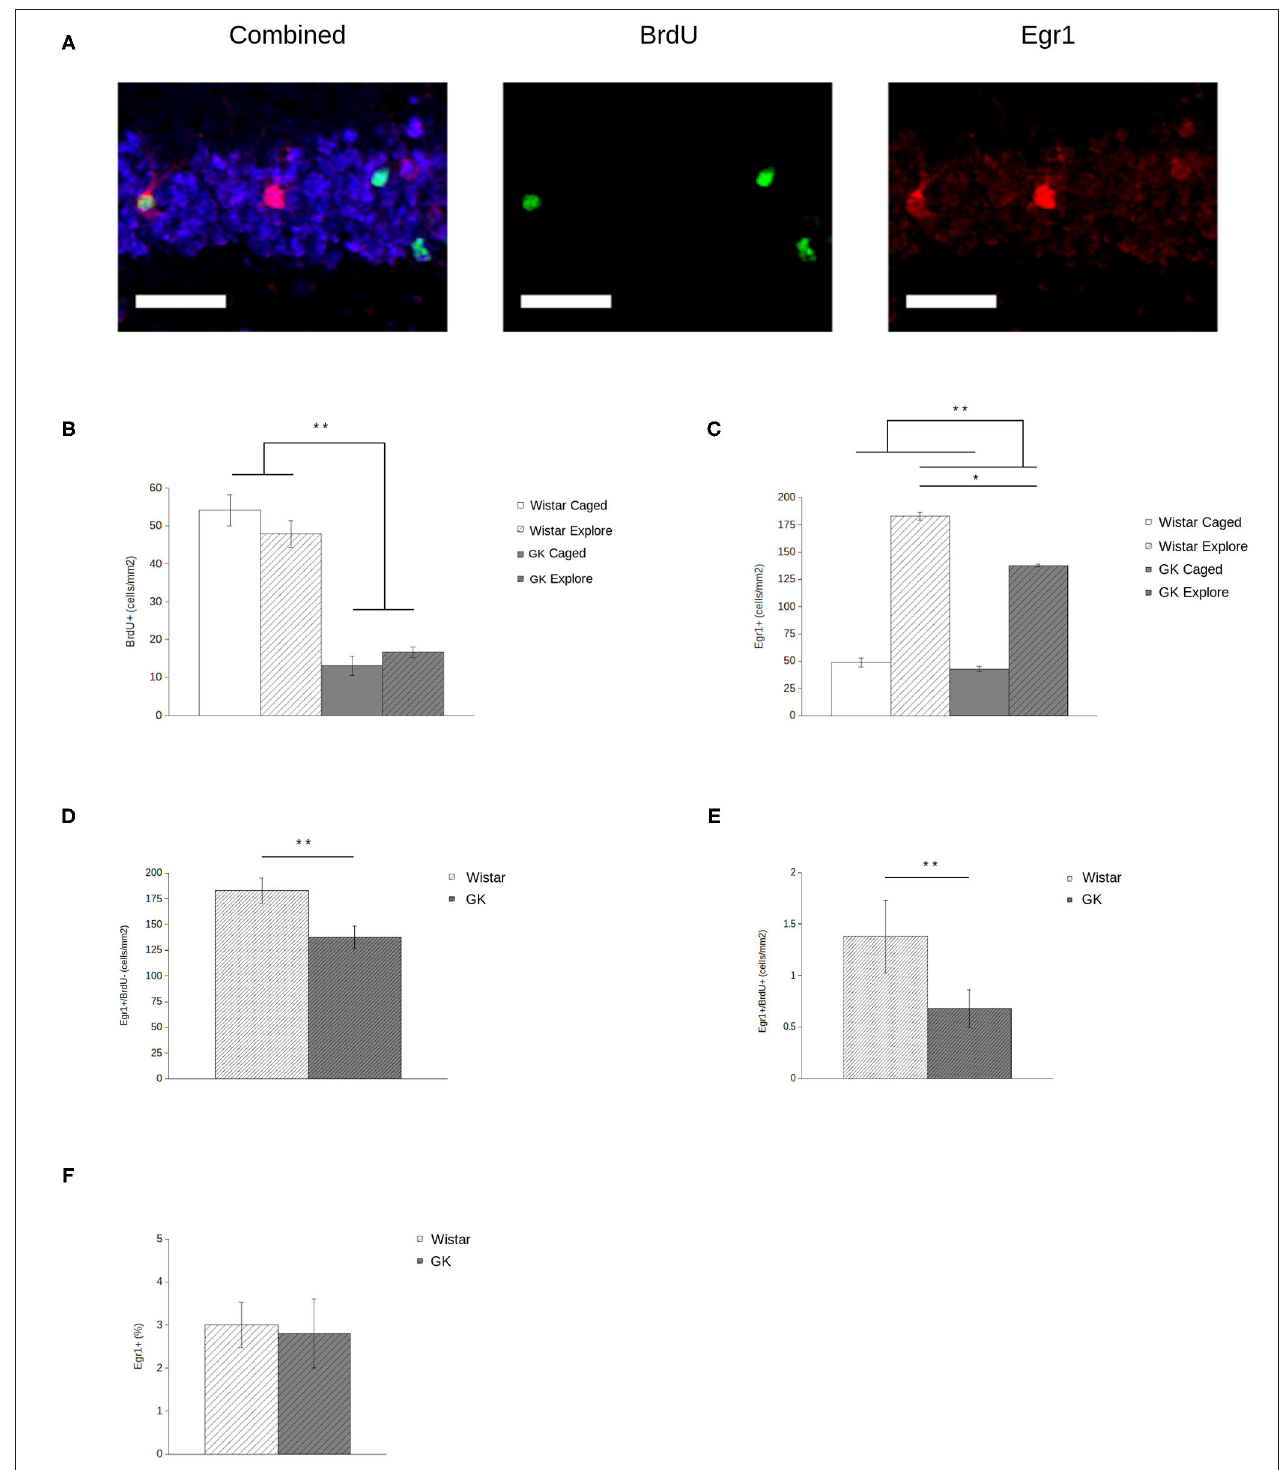
FIGURE 3 | Egr1 expression in adult-generated granule cells (agGCs) is preserved in Goto-Kakizaki (GK) rats. Sample confocal projection images ( A , scale bar = 50 µ m) show GCs labeled with NeuN (blue, left), BrdU (green, middle), and Egr1 (red, right) portraying examples of cells labeled with each marker, including a BrdU + /Egr1 + neuron. Quantitative data show that (B) fewer BrdU + cells were observed in GKs (gray) relative to Wistars (white) with no difference found between animals that explored a novel environment (hatched) relative to caged controls (solid). In addition (C) , fewer GCs express Egr1 in GKs relative to Wistars, although exploring animals show more Egr1 + GCs than caged controls. When analyzing newborn BrdU + (D) and older BrdU- (E) GCs by volume, both show a significant